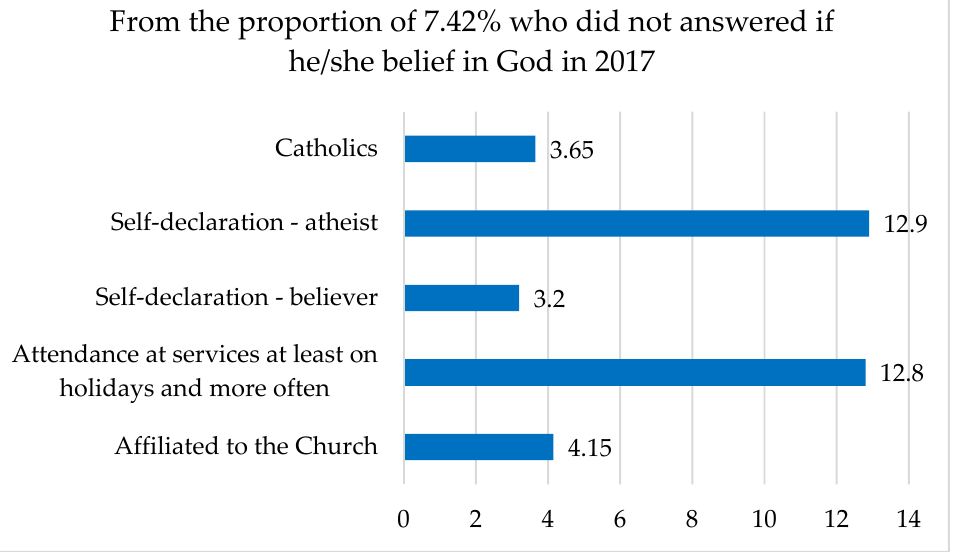
Figure 3. Basic characteristics of those who did not answer the question about belief in God in 2017 (%).